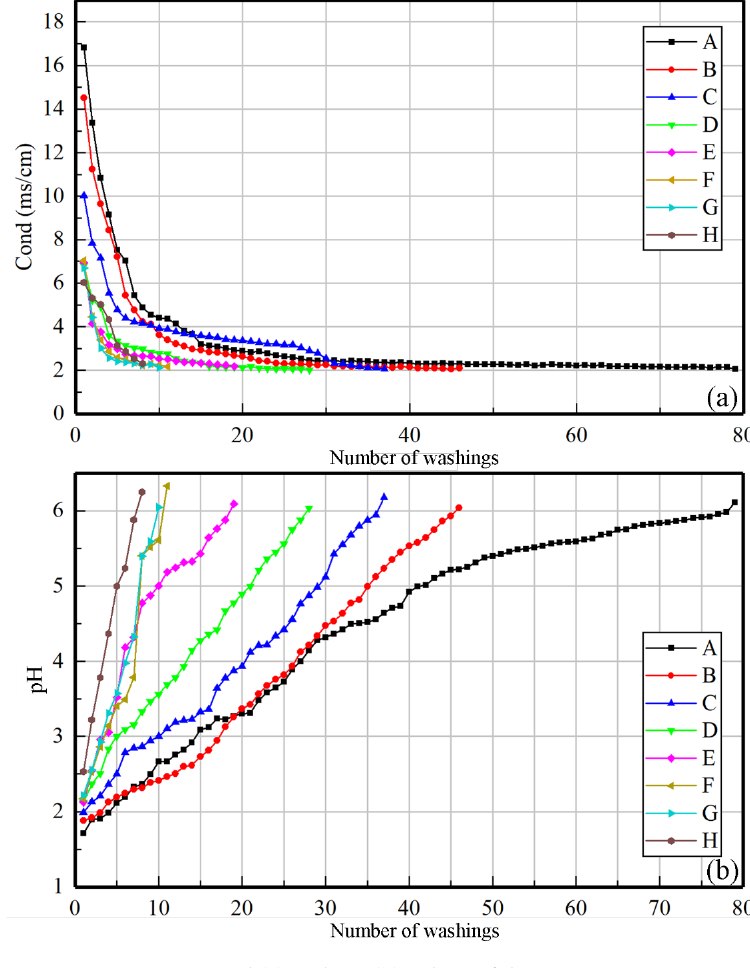
Figure 3. Cond ( a ) and pH ( b ) values of the supernatant. Minerals 2019 , 9 , 175